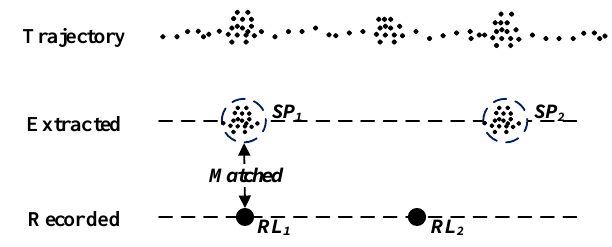
Figure 7. An example of the matched point.